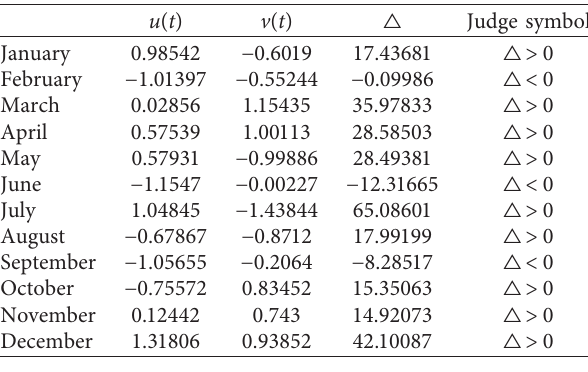
Table 5: The principal component analysis in 2019.